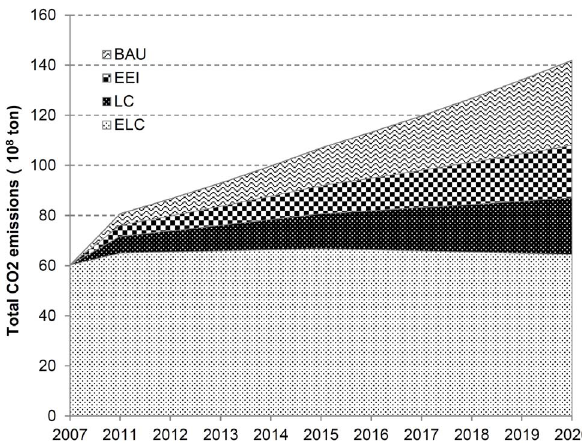
Figure 4. China’s energy-related CO 2 emissions under BAU, EEI, LC and ELC scenarios. (Scenarios are defined in Table